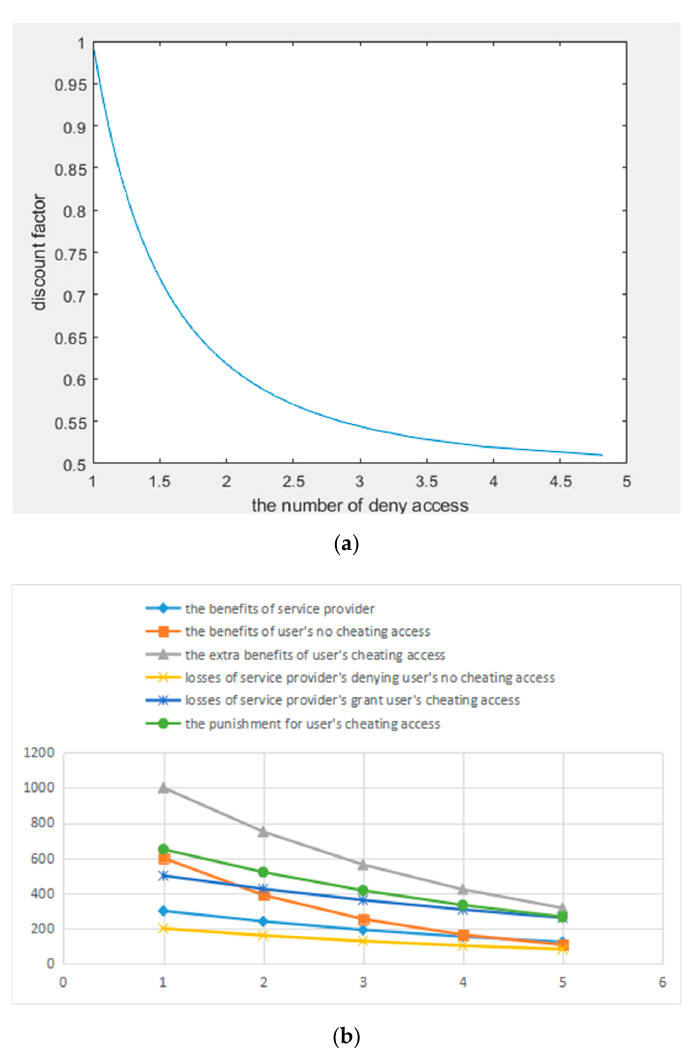
Figure 1. ( a ) The relationship between discount factor and the number of denial times of the service provider in the access control game model without user trust; ( b ) The utility curve of the user and the service provider based on the user’s trust level.